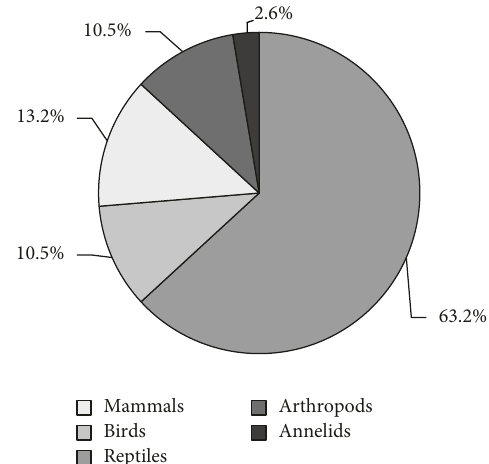
Figure 3: Percentage of animal taxonomic groups being used in zootherapeutic practices among the traditional healers of Assosa